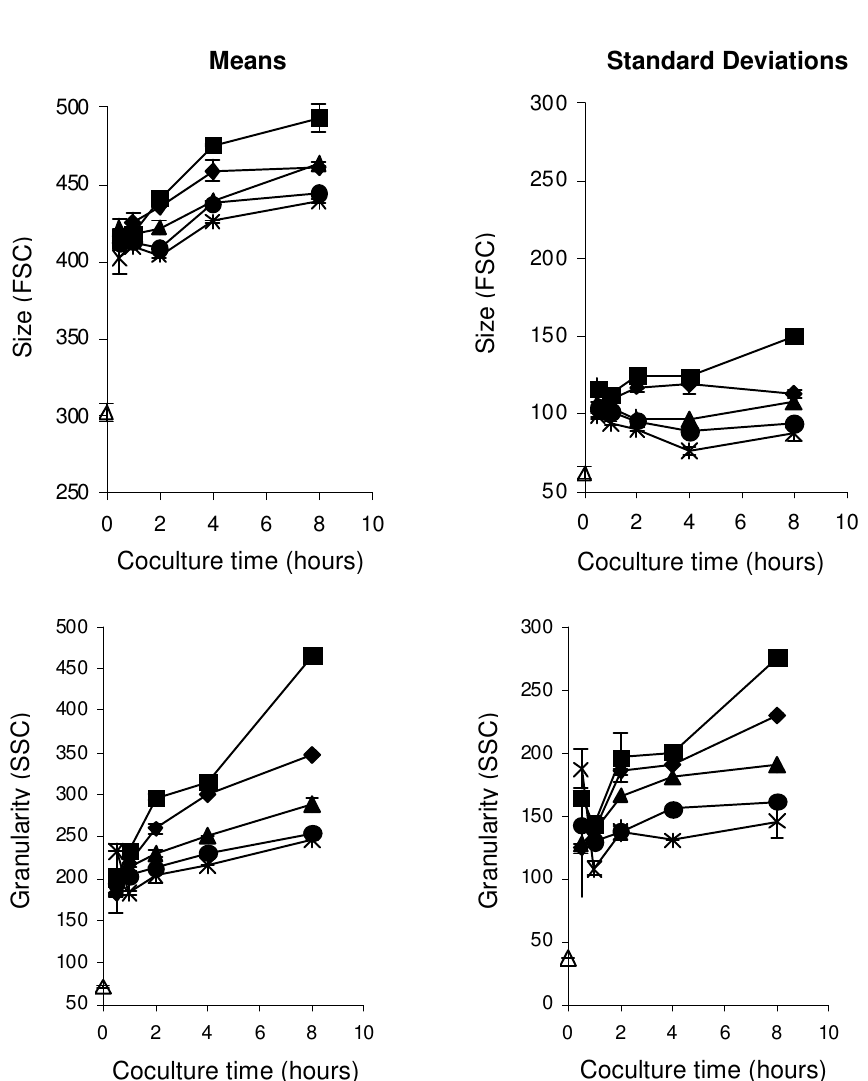
FIGURE 8. Changes in syncytia size (FSC) and granularity (SSC) with R 0 and time of coculture. (cid:1) , R 0 = 10; (cid:1) , R 0 = 2.4; (cid:1) , R 0 = 1; (cid:2) , R 0 = 0.5; (cid:1) , R 0 = 0.1; (cid:2) , unfused CD4 + cells. (Reprinted from